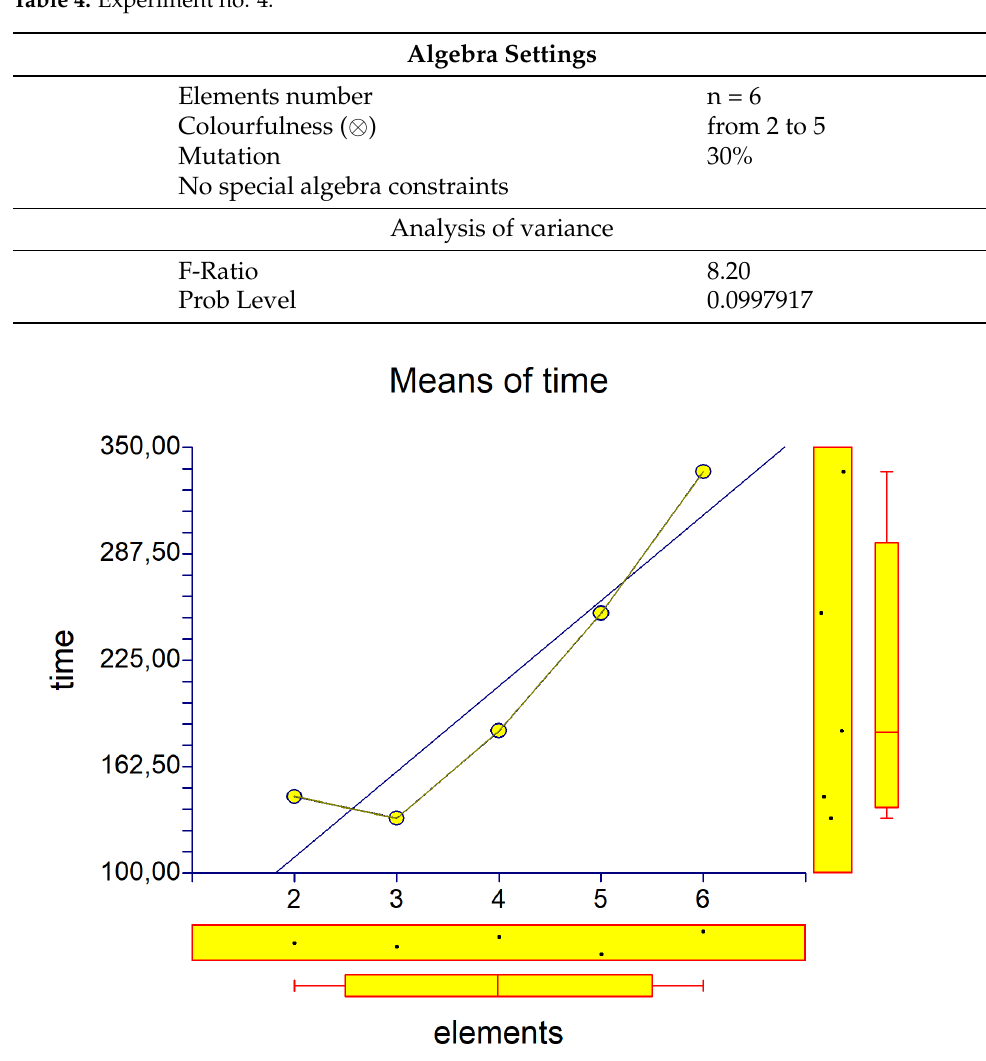
Figure 14. Exp. no. 4—Box